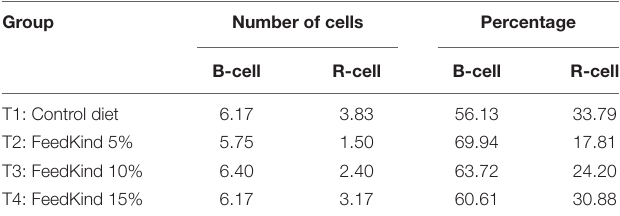
TABLE 4 | Number and percentage of B-cell and R-cell from hepatopancreas of shrimp fed different levels of methanotroph bacteria meal for 6 weeks under pre-challenge